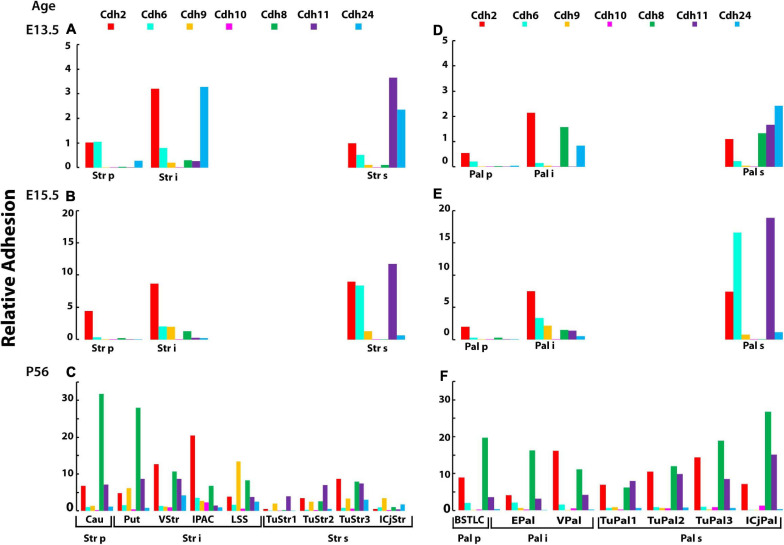
Developmental changes in cadherin mediated-relative adhesion associated with the formation of brain nuclei in the central subpallium (corpus striatum and globus pallidus). The relative adhesion values of Cdh2, cadherin type II group A (Cdh6, Cdh9, and Cdh10) and group C (Cdh8, Cdh11, and cdh24) were calculated based on mRNA expression level (detected by ISH) and binding affinity (see section “Materials and Methods”) in the brain nuclei derived from the mantle zone of the striatum and pallidum. (A,D) Relative adhesion at E13.5 in the three strata of the striatal and pallidal subdivisions, respectively; (B,E) relative adhesion at E15.5 in the striatal and pallidal subdivisions, respectively; and (C,F) relative adhesion at P56 in the nuclei derived from the three strata in the striatum and globus pallidus, respectively. Str, striatum; Pal, globus pallidal complex; p, periventricular stratum; i, intermediate stratum; s, superficial stratum; Cau, caudate nucleus; Put, putamen, VStr, ventral striatum; IPAC, interstitial nucleus of the posterior limb of the anterior commissure; LSS, laterostriatal stripe; TuStr, striatal part of olfactory tuberculum; ICjStr, striatal islands of Calleja; BSTLC, bed nucleus of the stria terminalis laterocentral division; EPal, external globus pallidum; VPal, ventral pallidum; TuPal, pallidal part of olfactory tuberculum; ICjPal, pallidal islands of Calleja.